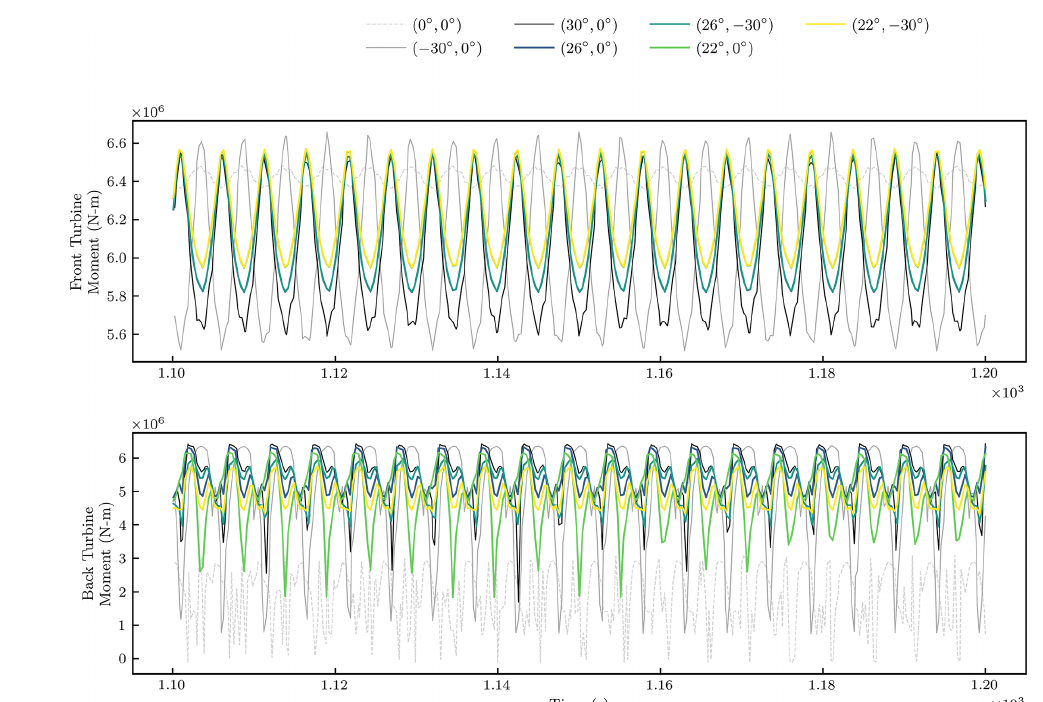
Figure 8. Loading histories associated with different yaw offset strategies (values of γ